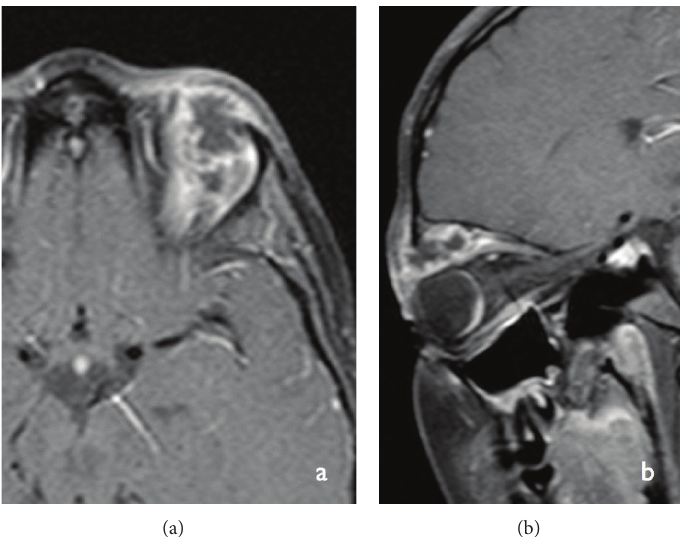
Figure7:Contrast-enhancedaxial(a)andsagittalT1-weightedMRIimageshowingthechoroidalretinalmassandtheperipherallyenhancing lobulated lesion in the superior lateral extraconal plane centered in the region of the left lacrimal gland.